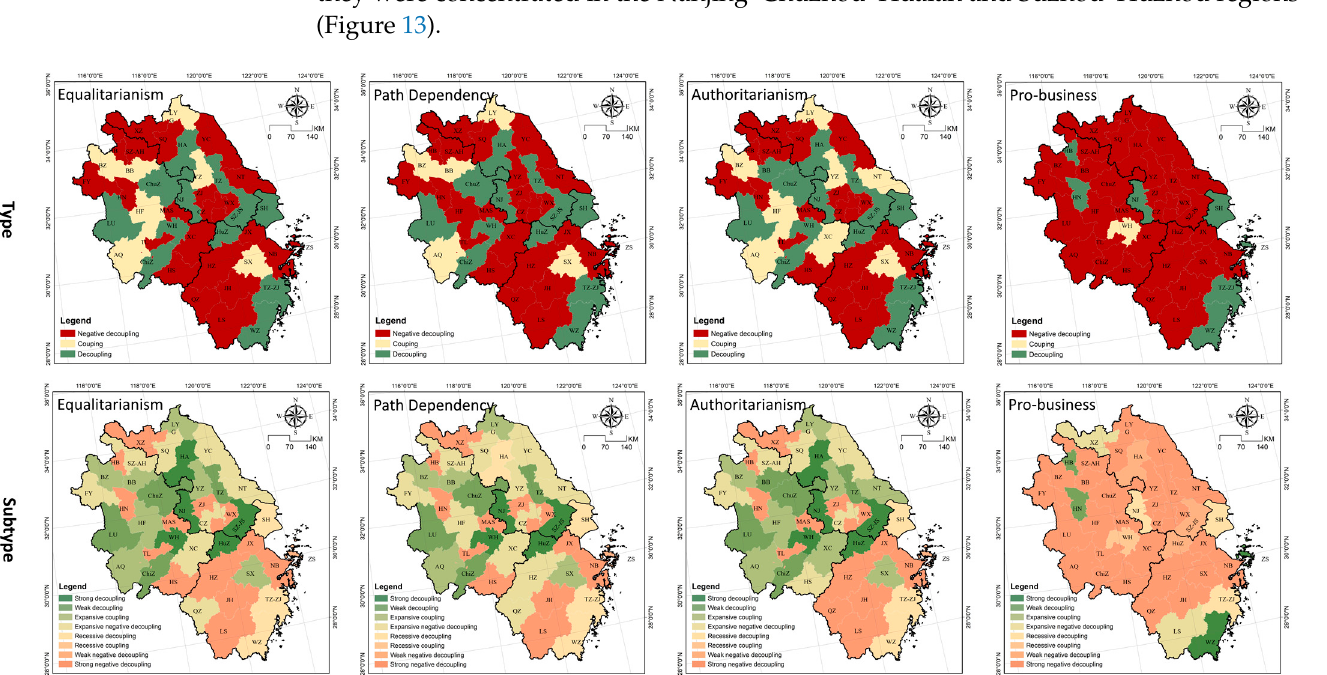
Figure 13. Spatial analysis of decoupling types based on different weights in the YRD.